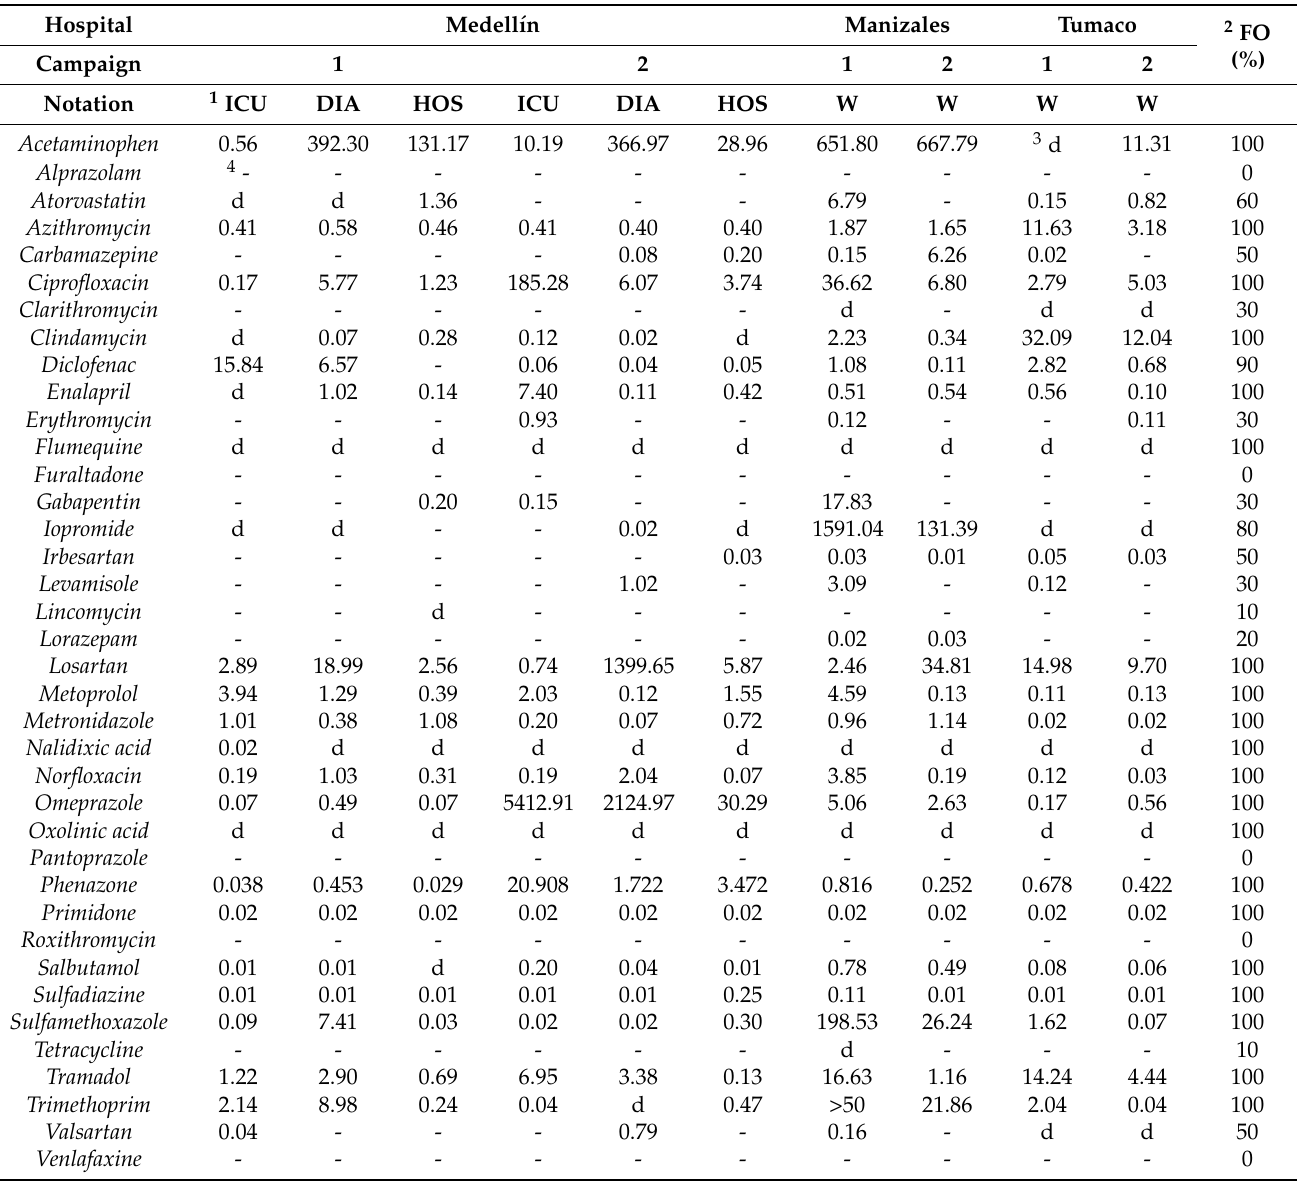
Table 2. Measured concentration (MEC) of the target pharmaceuticals (in µ g L − 1 ) in the consid- ered